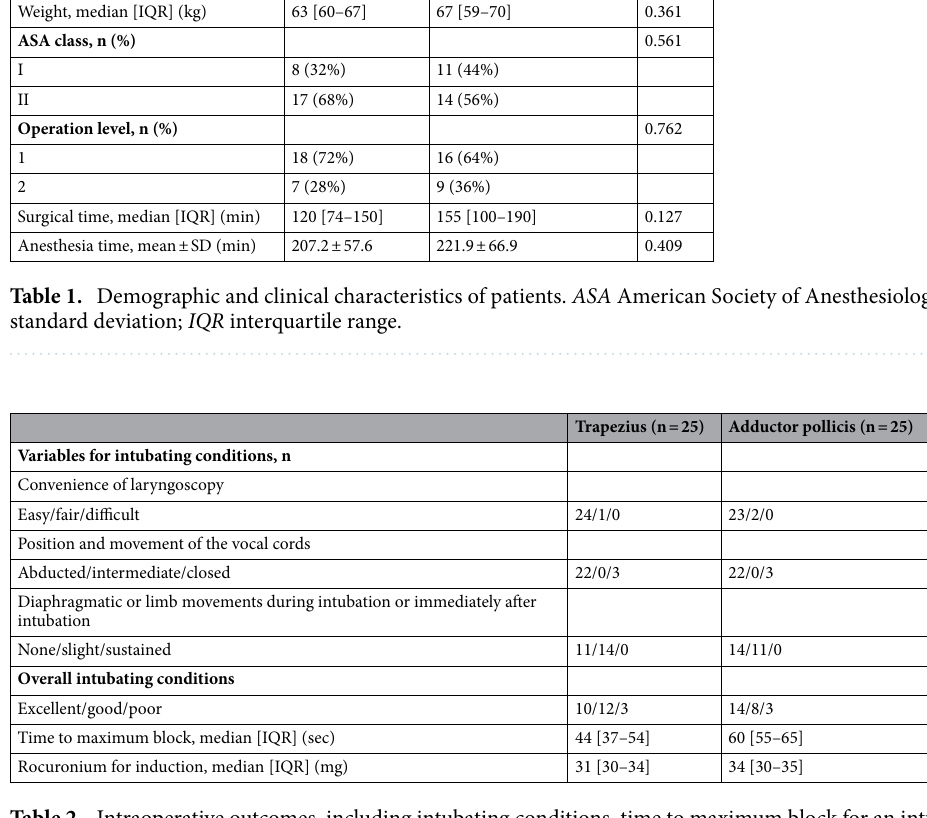
Table 2. Intraoperative outcomes, including intubating conditions, time to maximum block for an intubating dose, and rocuronium dose for induction. IQR indicates interquartile range.